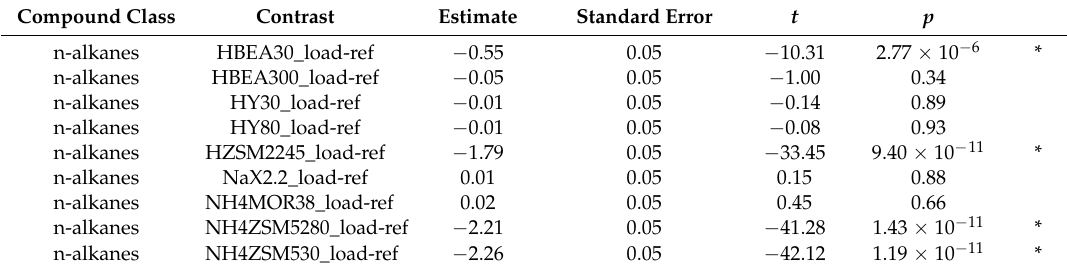
Table 4. Results of the post hoc tests on the Aitchison transformed data to assess the difference between the proportions of n-alkanes and 3-methylalkanes present in the hexane extracts of the loaded zeolites compared to the reference (synthetic alkane mixture). Due to the presence of only two different compound classes, the results for both classes are identical with the exception of the sign of the estimate, which would be opposite for the 3-methylalkanes. The estimates are given together with their standard errors, t - and p -values from which the significance can be determined. * indicates a significant difference ( p < 0.05).